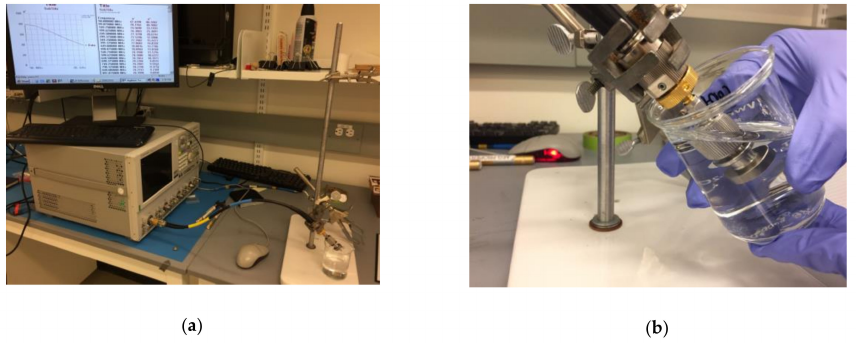
Figure 1. ( a ) Overall measurement setup including dielectric probe (87050E, Keysight Technologies), vectornetworkanalyzer(E8364B,KeysightTechnologies), andsolutionundertest(SUT)and( b )dielectric probe immersed in